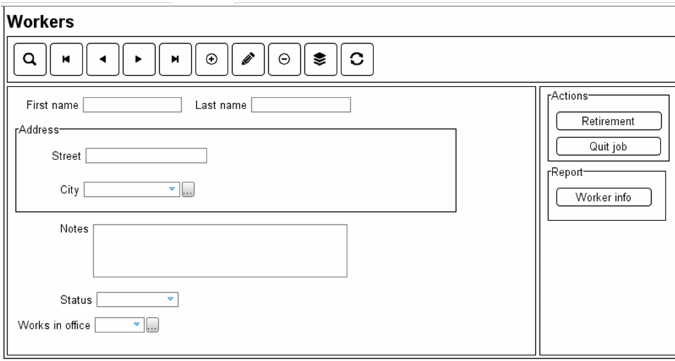
Figure 9. An example specification in the UML editor.